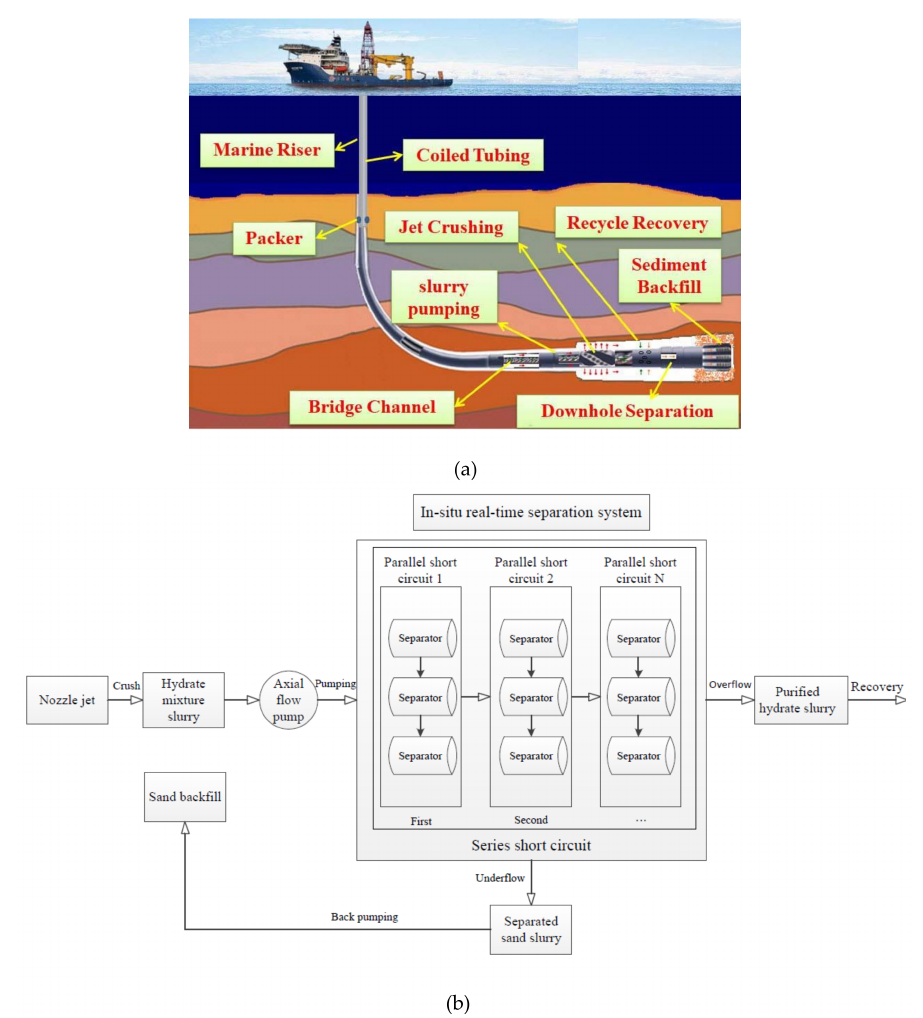
Figure 1. The exploitation ( a ) and separation ( b ) process of shallow seabed non-diagenetic gas